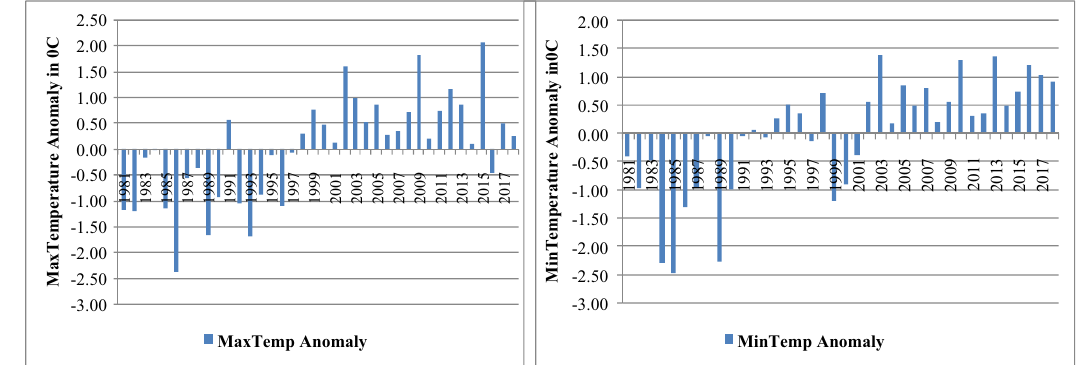
Figure 8: Anomalies of maximum and minimum temperature in te ff growing areas, 1981 –